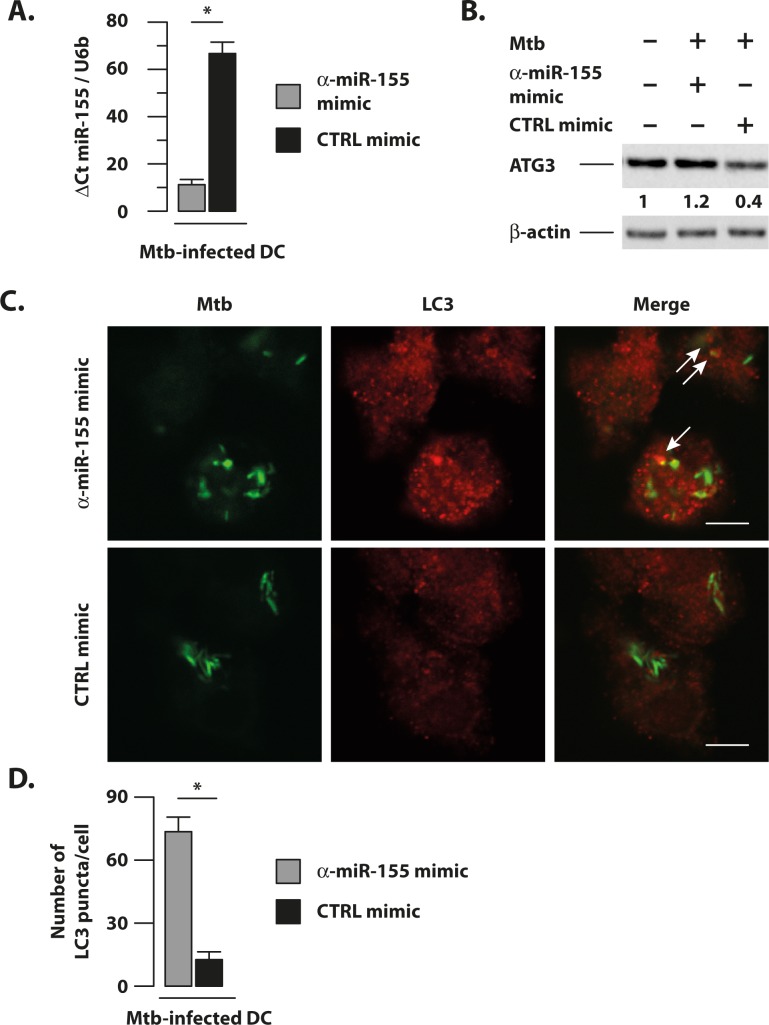
Silencing of Mtb-induced miR-155 expression restores DC ability to form autophagosome.DC were left untreated (CTRL) or infected for 8 hours with Mtb at MOI of 1 bacterium/cell and then transfected with 100 nM of an antagomir oligonucleotides for miR-155 (α-miR155 mimic) or with a negative control mimic (CTRL mimic) for 24 hours. (A) Silencing of miR-155 expression was verified by qPCR analysis on total RNA samples. The results represent the mean ± the standard error of the mean of three independent experiments (*p = 0.03). (B) Atg3 protein levels were determined by immunoblotting analysis. Band intensity quantification for Atg3 is indicated at the bottom of each immunoblot. Actin levels were analyzed to verify the amount of loaded proteins. The results shown are from one of three experiments that yielded similar results. (C) Immunofluorescence analysis of the number of LC3 puncta per cell in DC infected with Mtb for 8 hours and then transfected with an antagomir oligonucleotides for miR-155 (α -miR155 mimic) or with a negative control mimic (CTRL mimic). Thirty-two hours after infection cells were fixed and then stained with auramine to color Mtb bacilli (green) and with an anti-LC3 antibody (red). Co-localization of LC3 puncta with Mtb bacilli is indicated by white arrows. A representative image for each condition is shown in panel C. Scale bar 15 μm. (D) Graphics reporting a quantification of the number of LC3 puncta per cell performed as indicated in Material and Methods. The results represent the mean ± standard error of the mean of three independent experiments (*p = 0.04).